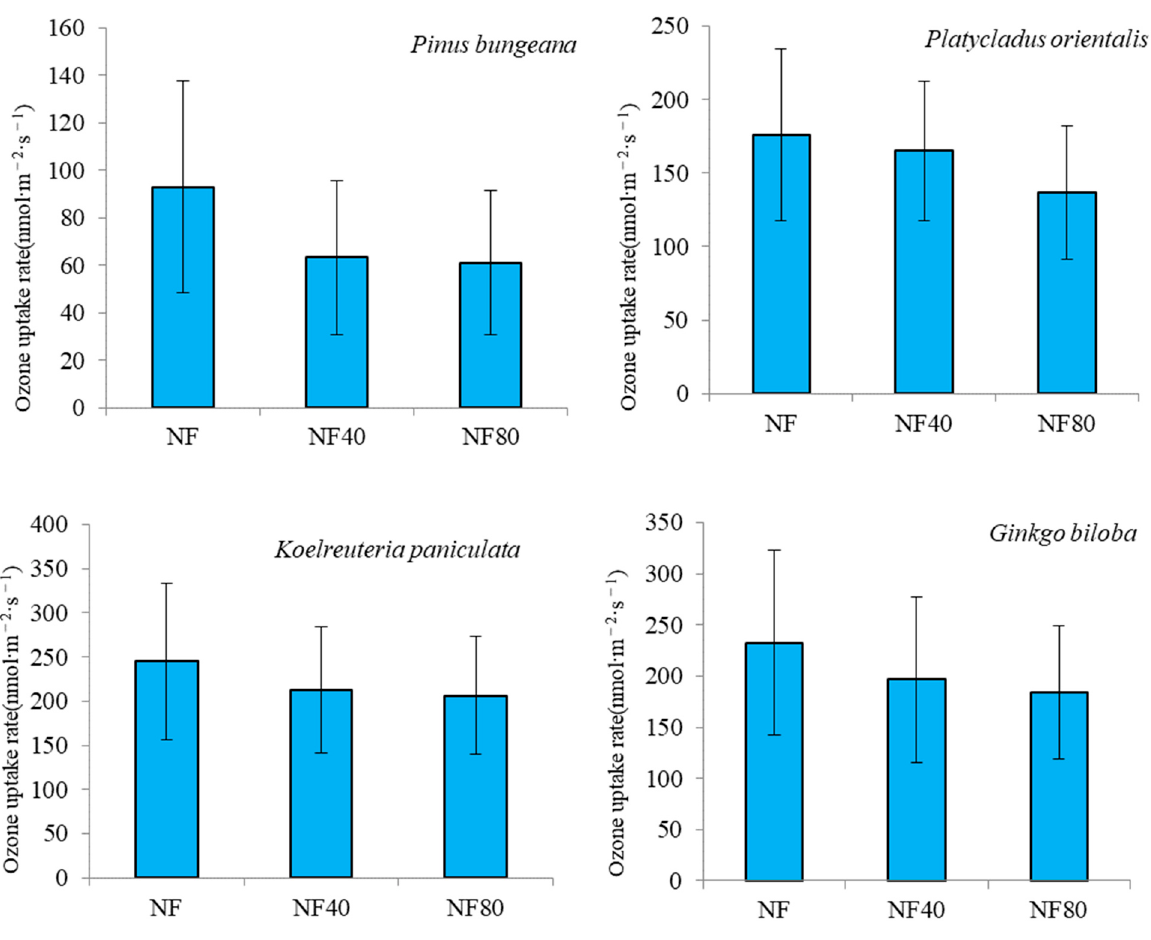
Figure 3. Variation of ozone uptake rate in forest canopy under different ozone